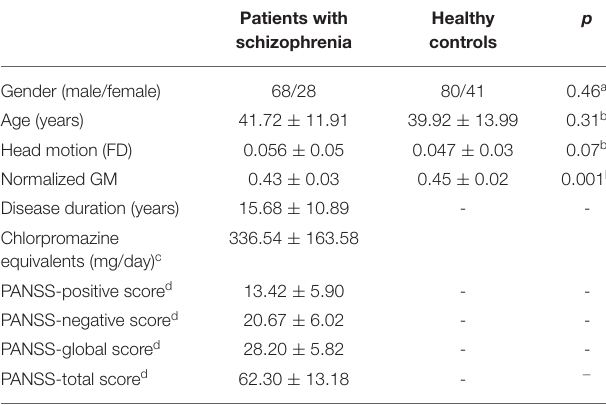
Indicated values are shown mean ± standard deviation. PANSS, Positive and Negative Symptom Scale; GM, gray matter. a Indicates the p-values from the comparison analysis (chi-square-test). b Indicates the p-values from the comparison analysis (two-sample t-test). c Data of 70 schizophrenic patients available. d Data of 64 schizophrenic patients